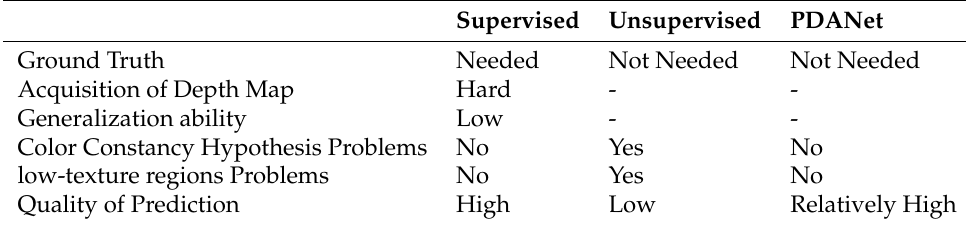
Table 1. Comparison of different approaches.